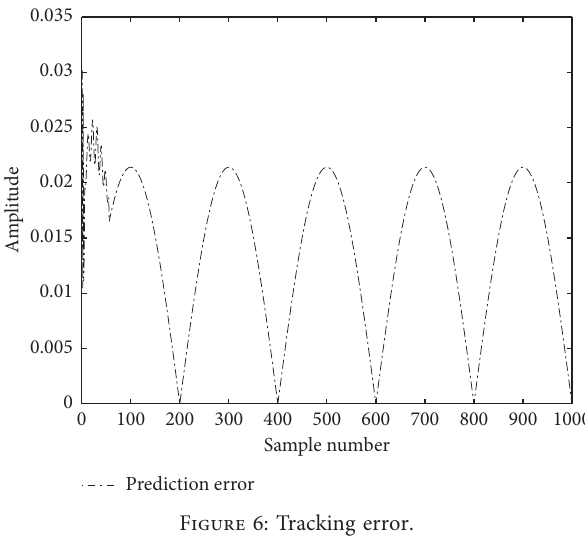
Figure 6: Tracking